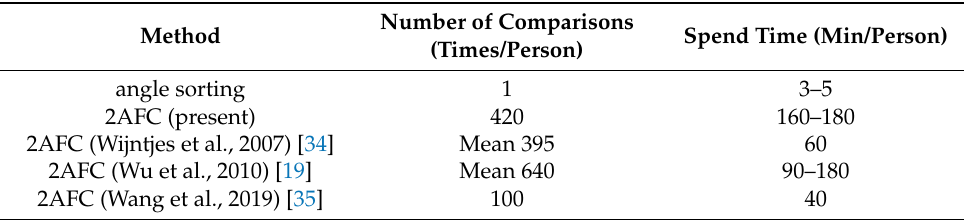
Table 2. Comparison of angle sorting and